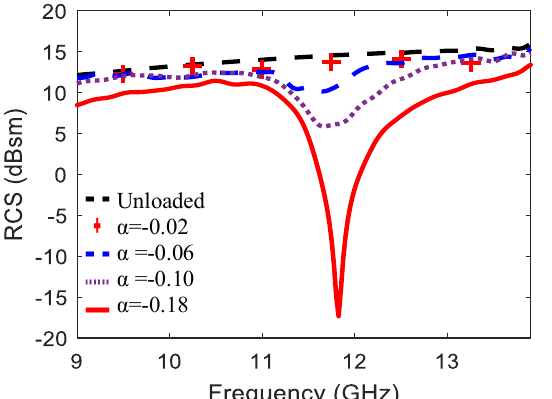
Fig. 13. The RCS versus frequency for two dimension holes tapering off-diagonal with different α, R o = 1.5 mm.